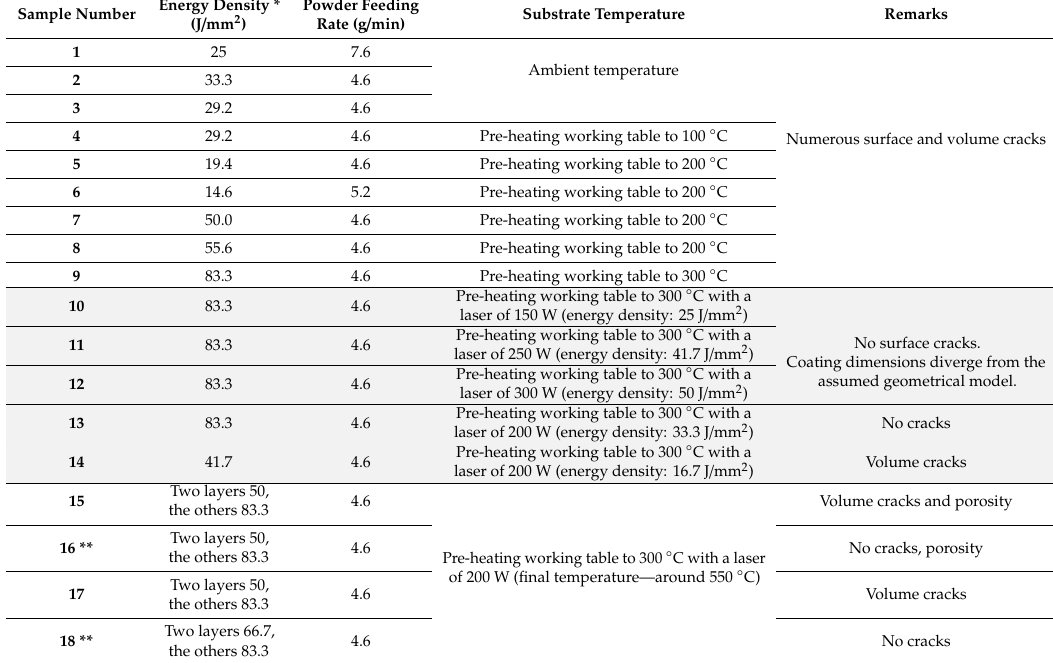
Table 3. The set of the LENS process parameters used during deposition of T-800 coatings. Sample Number Energy Density * (J / mm 2 )